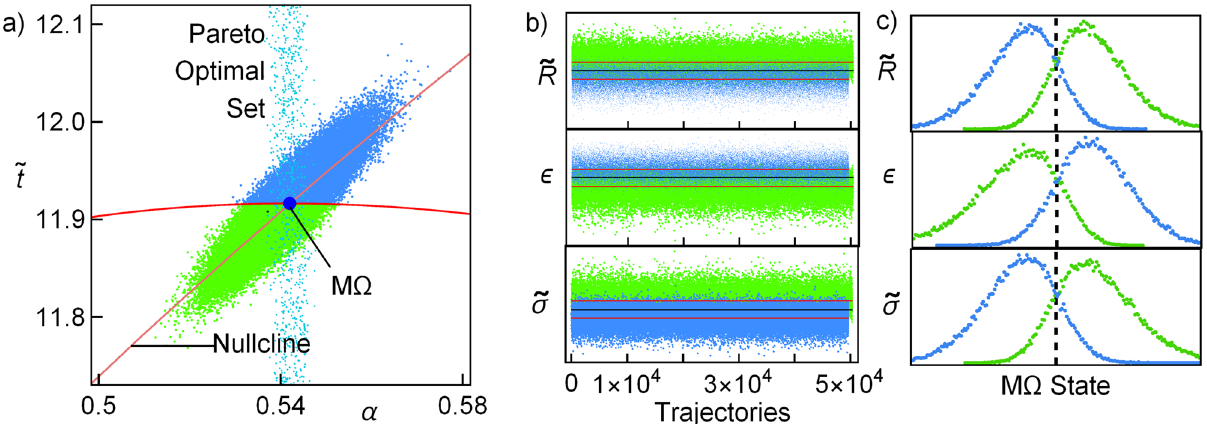
Figure 5. In ( a ) the final states after 10 5 cycles, each with 10 4 perturbations. In blue the points corresponding to states outside the stable region and in green points inside the stable region. There are slightly more points inside the stability region. The perturbations in this case allow for larger perturbations: M � � t / √ 2, t M � � t / √ 2 σ α , σ ; the relaxation time considered is t 1 t } = { α { } 1 / 2 . In ( b ) the mean values of the energetic properties obtained for each cycle. The mean values for all � c = trajectories are depicted as horizontal lines. In ( c ) the probability distribution function for the same energetic (cid:31) (cid:31) functions. For computing this, the size of the bins, or intervals, is such that the range of values of every function (cid:31) is distributed in √ 10 5 (square root of the number of trajectories) equal intervals.